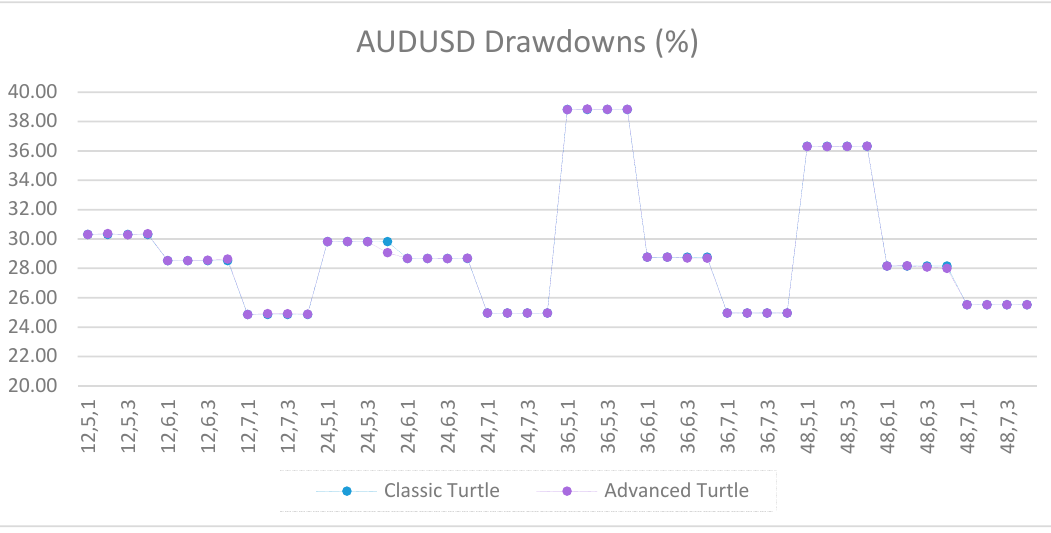
Figure A50. Drawdowns of BTCUSD as percentage of equity between the classic and the advanced Turtle systems for every combination of N, X, Y for the slow parameters (80, 160), where X ≥ 5.